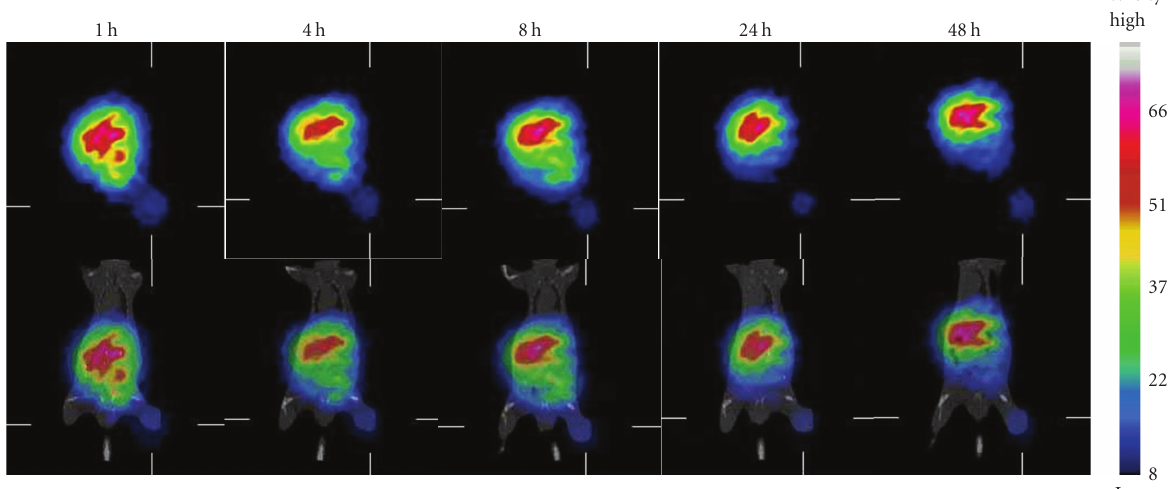
Figure 3: MicroSPECT/CT images of 111 In-AMBA targeting PC-3 tumors xenograft SCID mice. 12.2 MBq/4 μ g 111 In-AMBA was administered to each mouse by intravenous injection. The images were acquired at 1, 4, 8, 24, and 48h after injection. The energy window was set at 173keV ± 10% and 247keV ± 10%; the image size was set at 80 × 80 pixels. The color map shows the SPECT pixel values from 0 to the maximum expressed with an arbitrary value of 100.